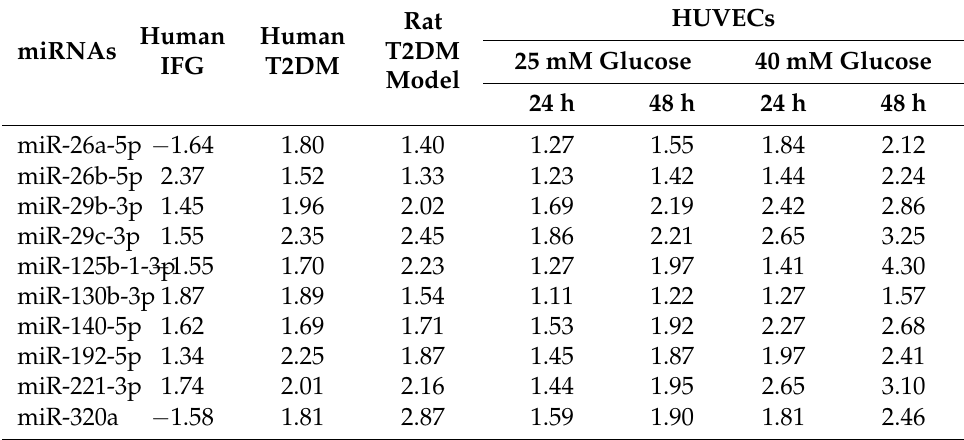
Table 1. Ten miRNAs selected from miRNA microarray analyses (human, rat and HUVECs) with statistical significance; p -value <